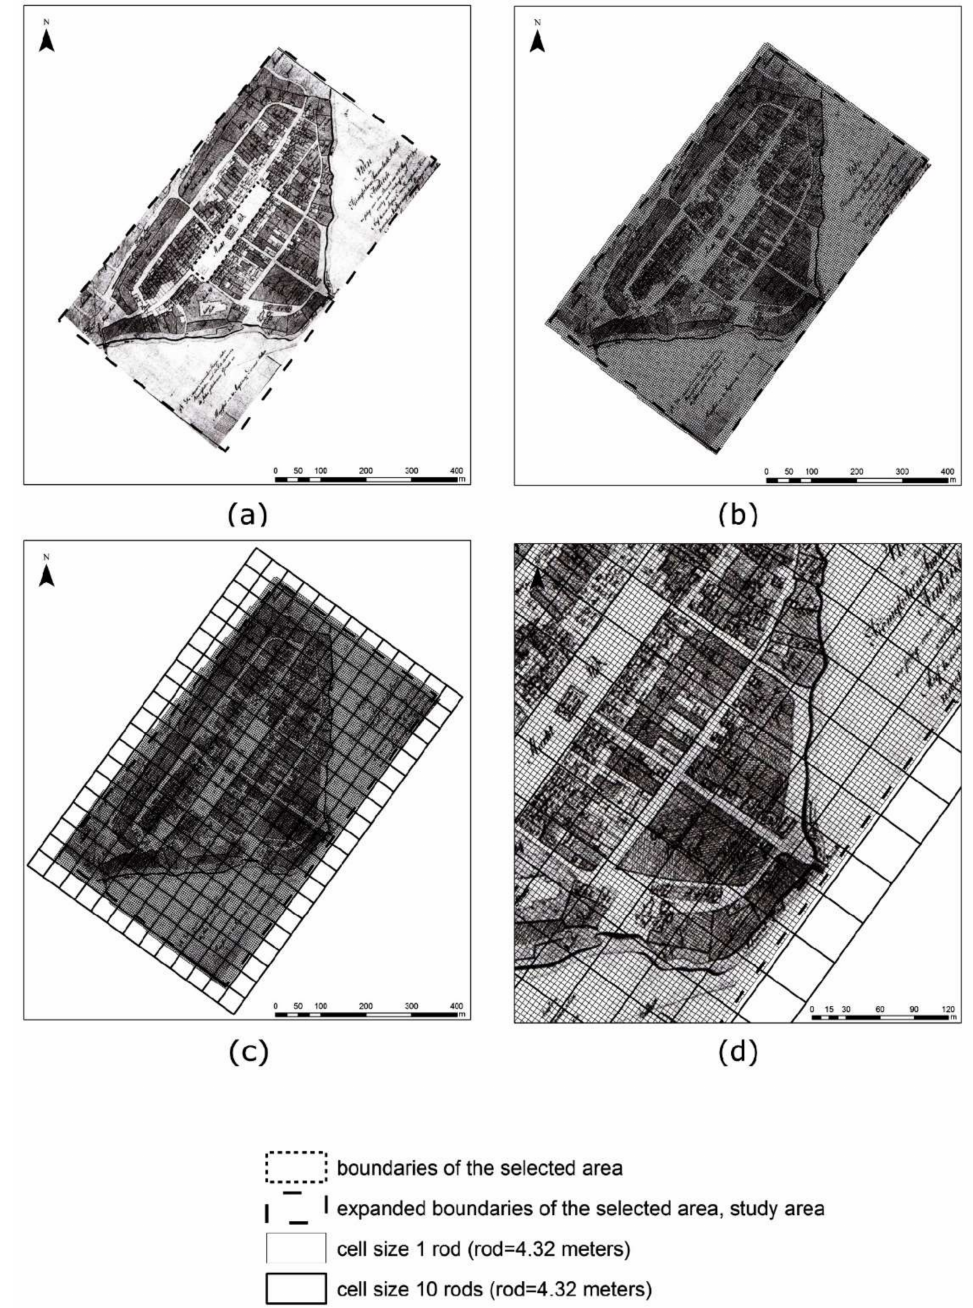
Figure 7. The use of HGIS tools. Example of Plan von der Königlichen Immediat Stadt Neuteich (Town plan) 1802: delimitation of the study area ( a ), creation of grid (cell size 1 rod) ( b ), imposition of a modular grid (cell size 10 rods) ( c ), zoom to the study area and searching for the principles of the modular layout of the city ( d